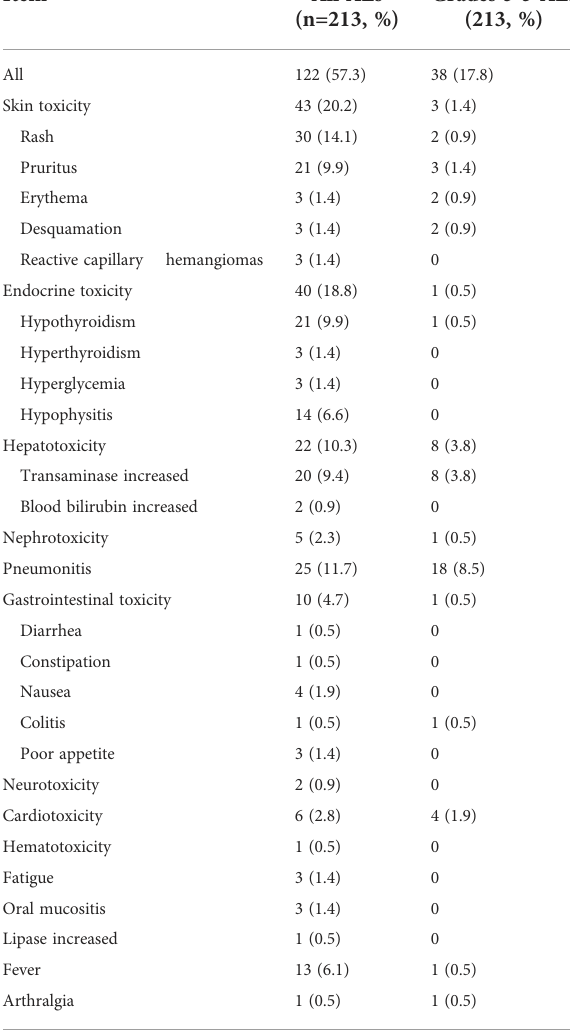
TABLE 2 Overall adverse